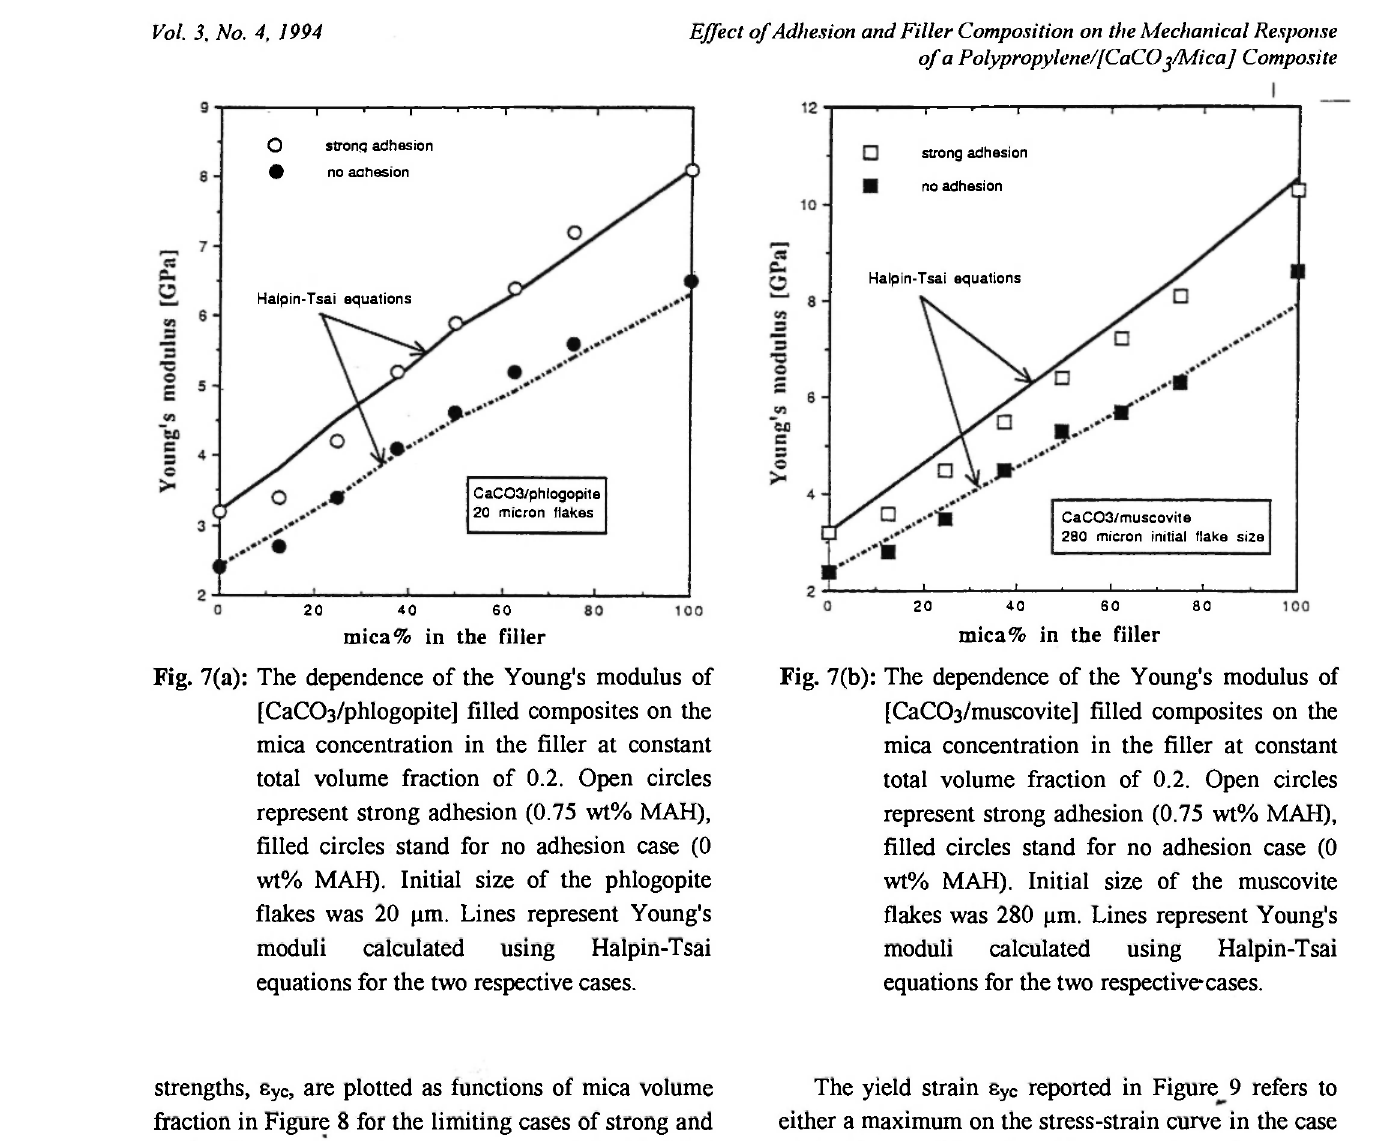
Fig. 7(b): The dependence of the Young's modulus of [CaCCb/muscovite] filled composites on the mica concentration in the filler at constant total volume fraction of 0.2. Open circles represent strong adhesion (0.75 wt% ΜΑΗ), filled circles stand for no adhesion case (0 wt% ΜΑΗ). Initial size of the muscovite flakes was 280 μπι. Lines represent Young's moduli calculated using Halpin-Tsai equations for the two respective·